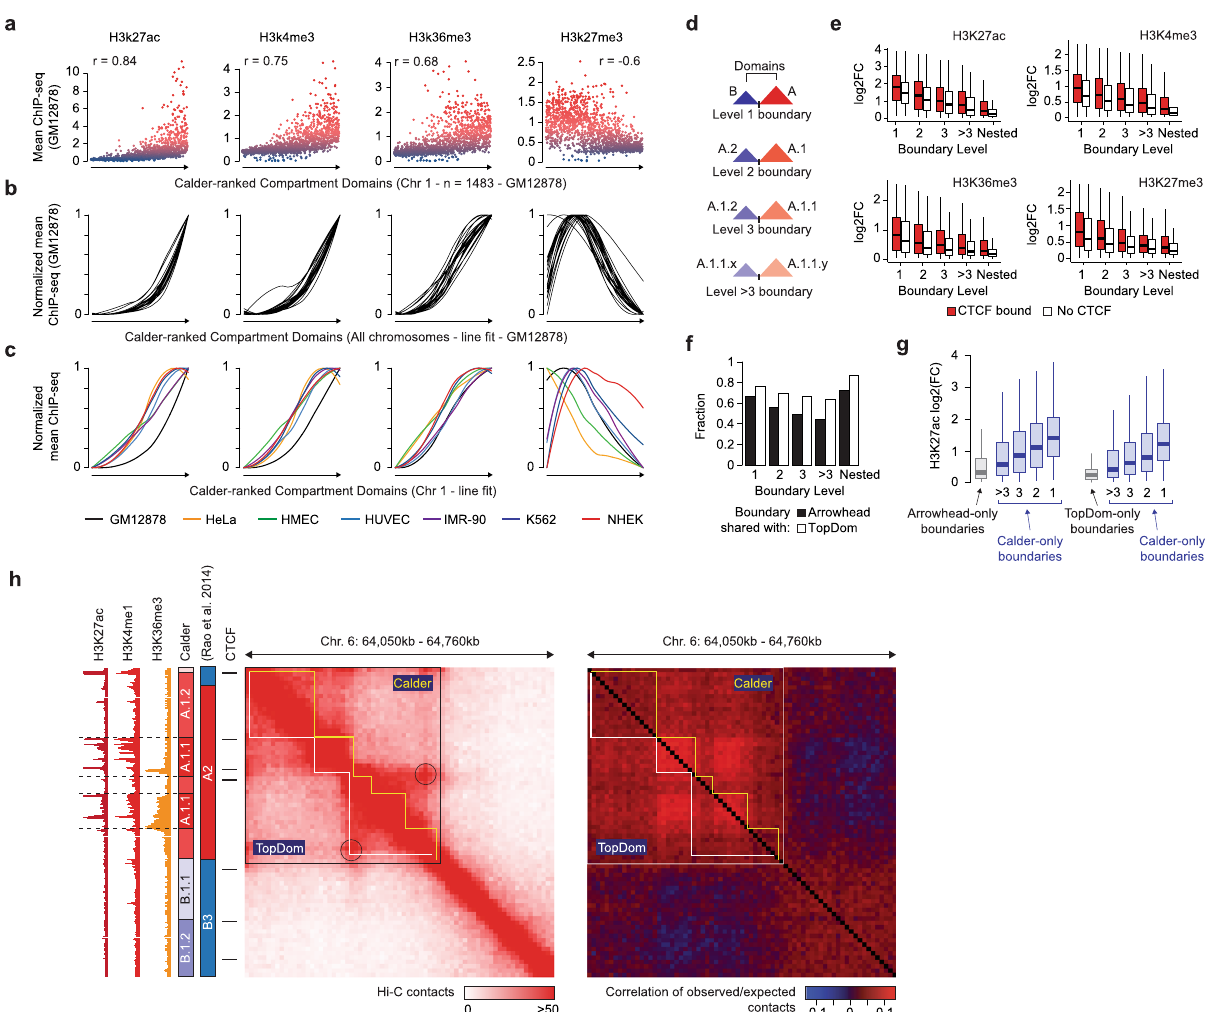
Fig. 2 Association between compartment domains, topologically associating domains, and histone modi fi cations. a ChIP-seq intensity of H3K27ac, H3K4me3, H3K36me3, and H3K27me3 for chromosome 1 compartment domains in GM12878. Each dot is a chromatin domain color coded by ChIP-seq intensity (blue-to-red). Domains were ordered by Calder-derived domain rank. r values are Spearman ’ s correlation coef fi cients. All correlation tests return p -values < 1E-100. b, c ) LOESS fi t lines of ChIP-seq intensity of H3K27ac, H3K4me3, H3K36me3, and H3K27me3 based on domain rank, for 22 chromosomes of GM12878 ( b ), and for chromosome 1 of GM12878, Hela, HMEC, HUVEC, IMR90, K562 and NHEK ( c ). Lines were normalized to the same maximum value. d Compartment domain boundaries are classi fi ed (Level 1, 2, 3, >3) based on the distance in the hierarchy of the domains separated by the boundary. e Fold-change of H3K27ac, H3K4me3, H3K36me3, and H3K27me3 ChIP-seq intensity at boundaries in GM12878, grouped by their level (from left to right) and presence/absence of CTCF (color coded). Each panel comprises n samples per boxplot with n = 1716, 2531, 2462, 2824, 2006, 2007, 2278, 1979, 850, and 1640 (from left to right). f Fraction of compartment domain boundaries inferred by Calder and inferred as TAD boundaries by arrowhead (black bars) and TopDom (white bars). g H3K27ac fold-changes at domain boundaries exclusively inferred by arrowhead (gray left), TopDom (gray right), and Calder (blue). Each panel comprises n samples per boxplot with n = 2296, 1411, 2339, 2054, 2383; 5860, 1003, 1597, 1351, 1551 (from left to right). h Visual comparison of compartment domains inferred by Calder (yellow track) and TADs inferred by TopDom (white track) on a Chr. 6 genomic region of the GM12878 cell line. The corner of the TAD identi fi ed by TopDom but not by Calder is circled. Domain tracks are overlaid to the Hi-C contact map (left) and the matrix of correlations of observed/expected contact ratios (right), which has been previously shown to reveal chromatin compartments. Subcompartment annotations and ChIP-seq tracks for H3K27ac (dark red), H3K4me1 (red), and H3K36me3 (orange) are shown on the left. The bounds of the boxplots in the plot are fi rst quartile ( Q 1 ) and third quartile ( Q 3 ). The lower and upper whiskers are computed by extending the box bounds by 1.5* IQR , where IQR = Q 3 − Q 1